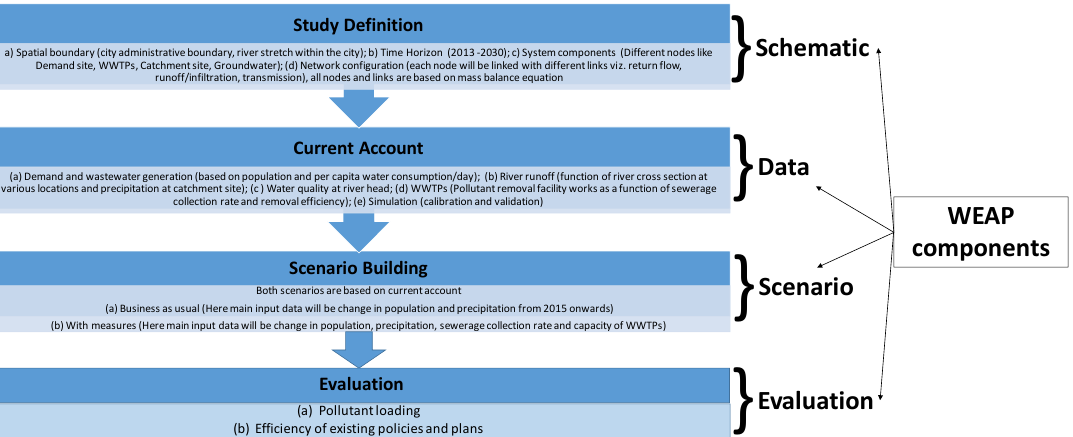
Figure 2. Flowchart showing work framework.